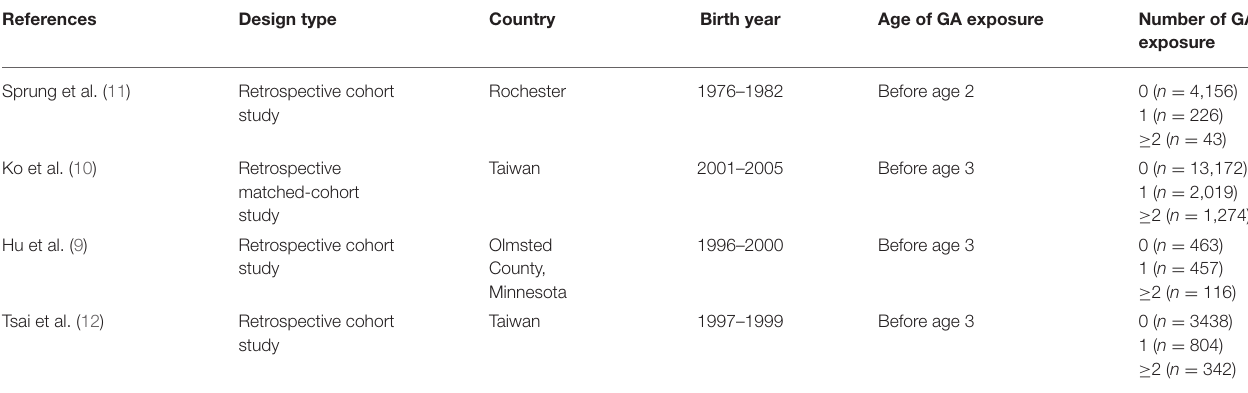
TABLE 1 | Summary of included